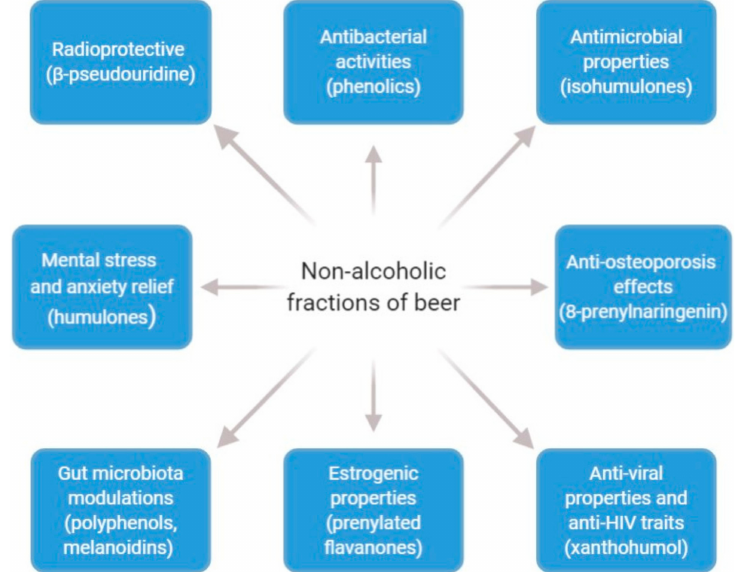
Figure 2. Beneficial properties of beer’s nonalcoholic fractions and their supposed responsible compounds, requiring up-to-date in vitro and in vivo